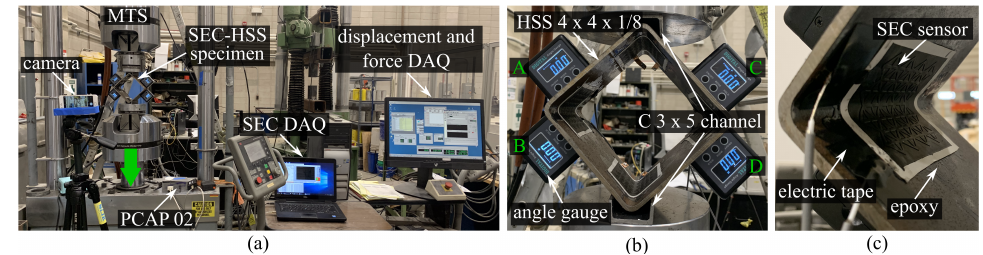
Figure 4. ( a ) Overall experimental configuration (green arrow indicates the loading direction);